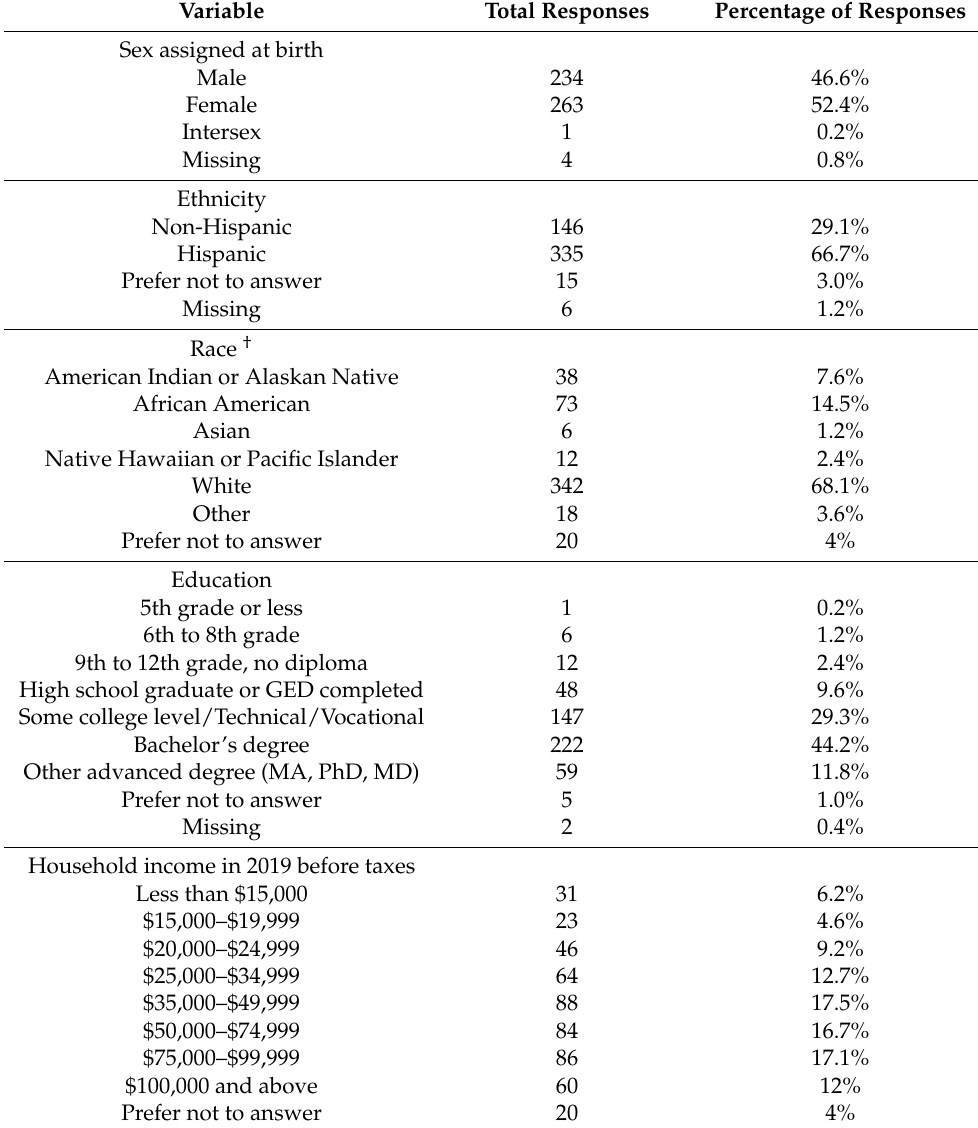
Table 1. Demographic characteristics ( N =